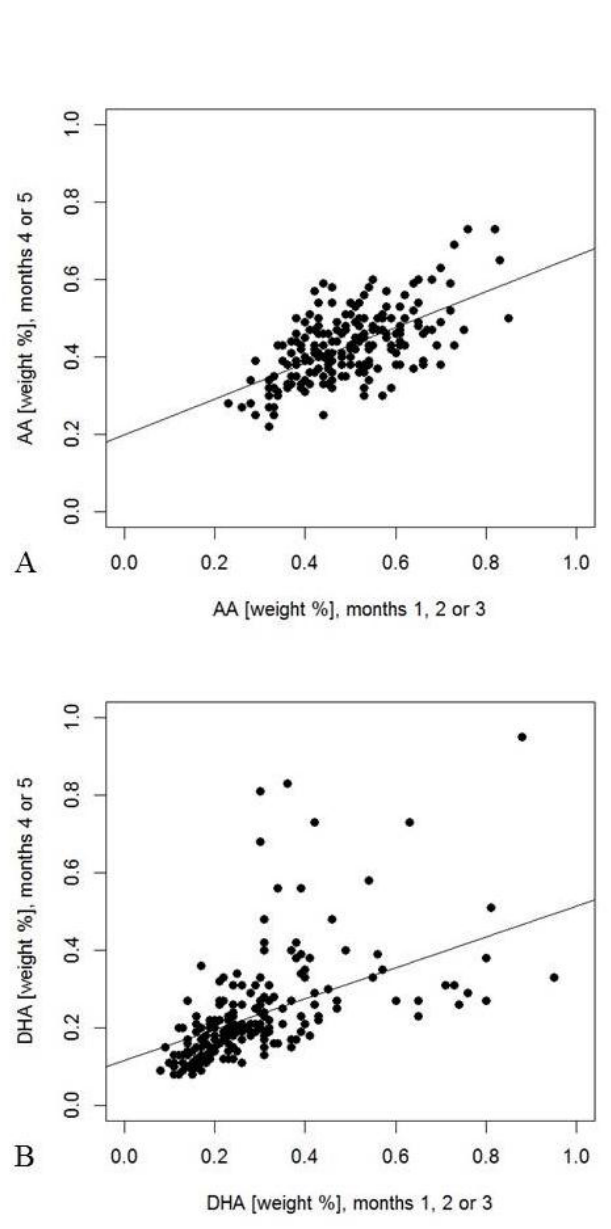
Figure 3. Weight percentages of arachidonic acid (AA) (( A ), r = 0.58, p < 0.001) and docosahexaenoic acid (DHA) ( B ), r = 0.63, p < 0.001) measured in both early and late milk samples. Percentages were calculated for 202 mothers, who had provided samples during the first three months or during the fourth or fifth month of lactation, respectively.